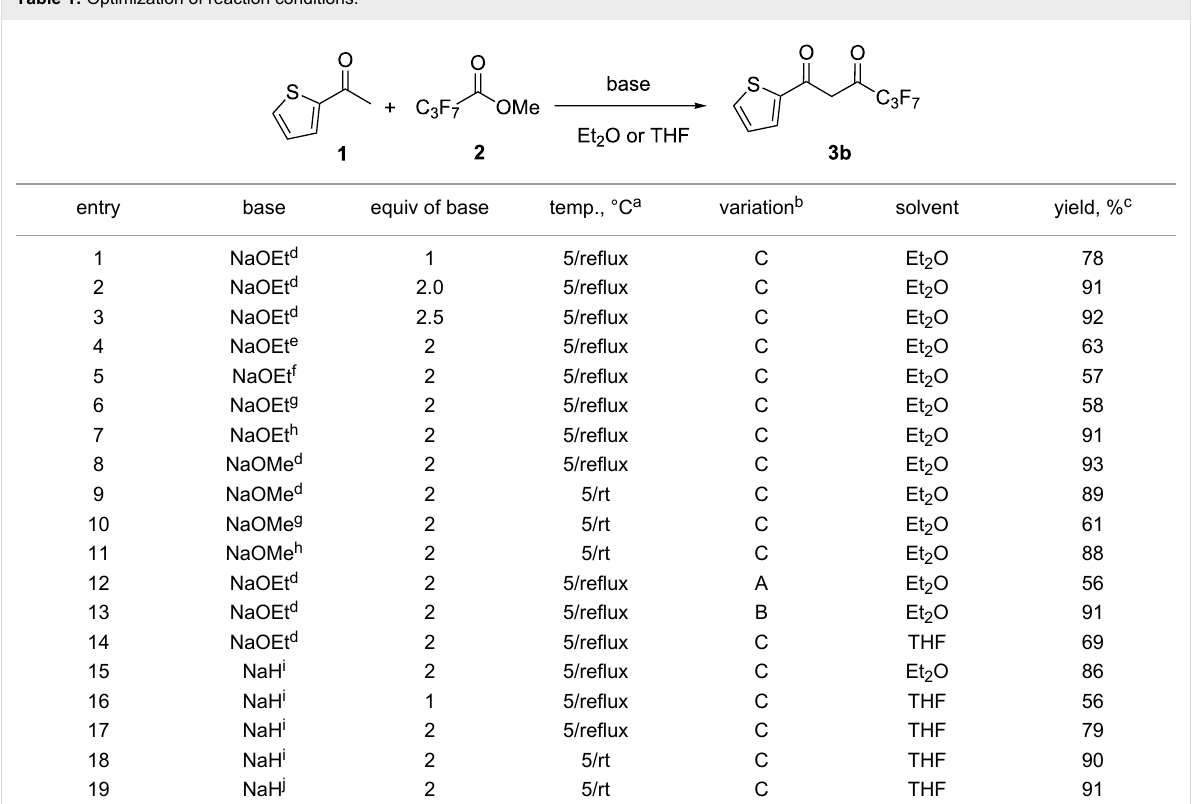
Table 1: Optimization of reaction